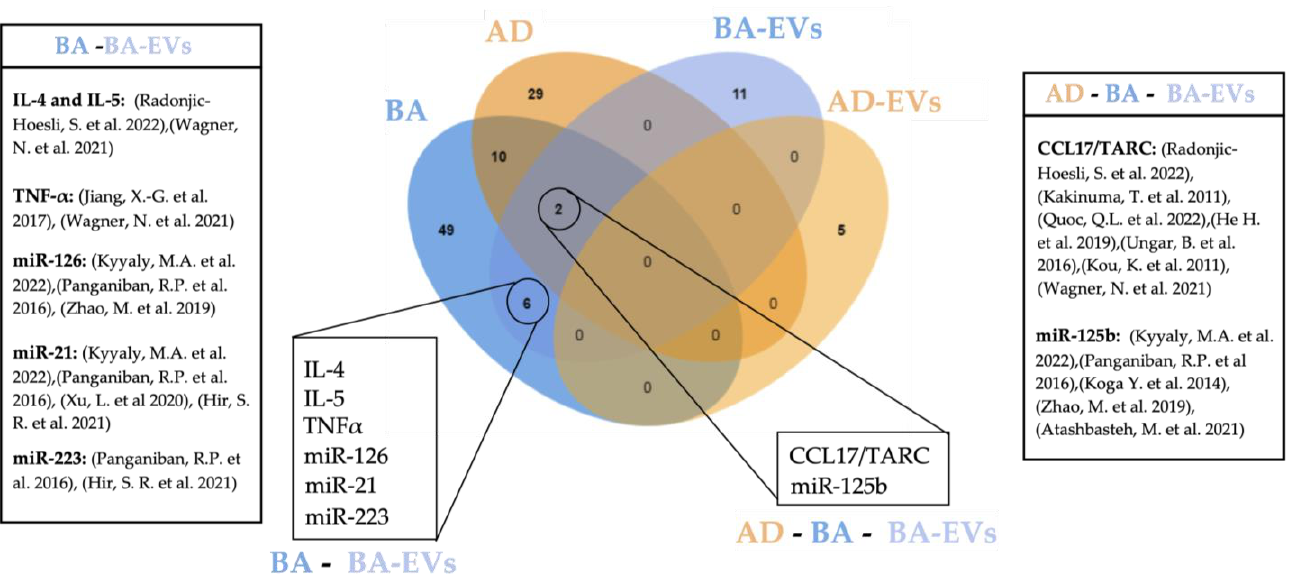
Figure 2. Venn diagram showing overlapping circulating biomarkers for BA, AD, BA-EVs, and AD- EVs [65–68,83–85,101,107,108,138,184–188]. Created with Jvenn diagram viewer [173]. BA: bronchial asthma, BA-EVs: bronchial asthma extracellular vesicles, AD: atopic dermatitis, AD-EVs: atopic dermatitis extracellular vesicles.